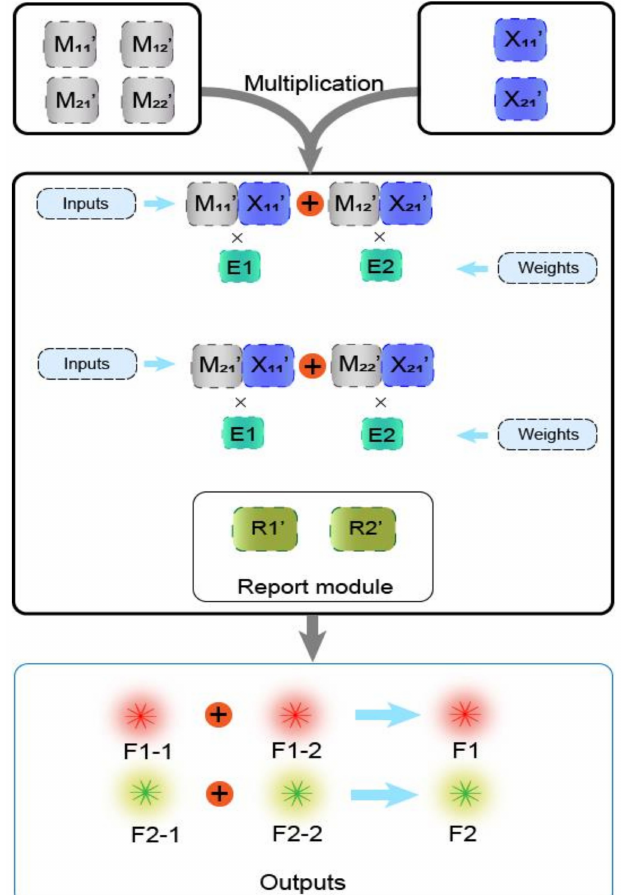
Figure 6. Schematic diagram of the weighted sum of 2 × 2 matrix multiplication based on the mecha- nism of the DNAzyme binding to double auxiliary strands to cleave the